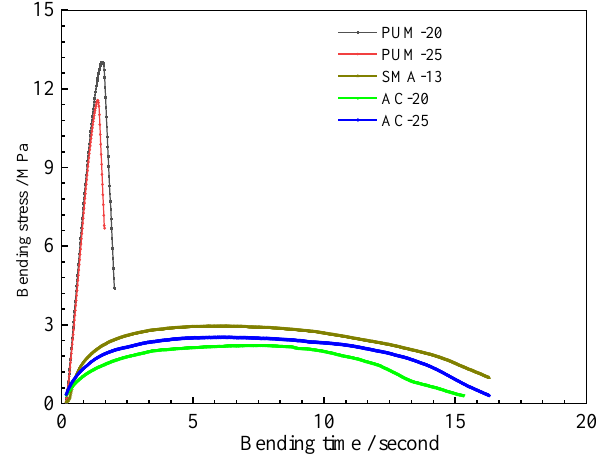
Figure 12. Time–stress curve. Figure 12. Time – stress curve. Figure 12. Time – stress curve.